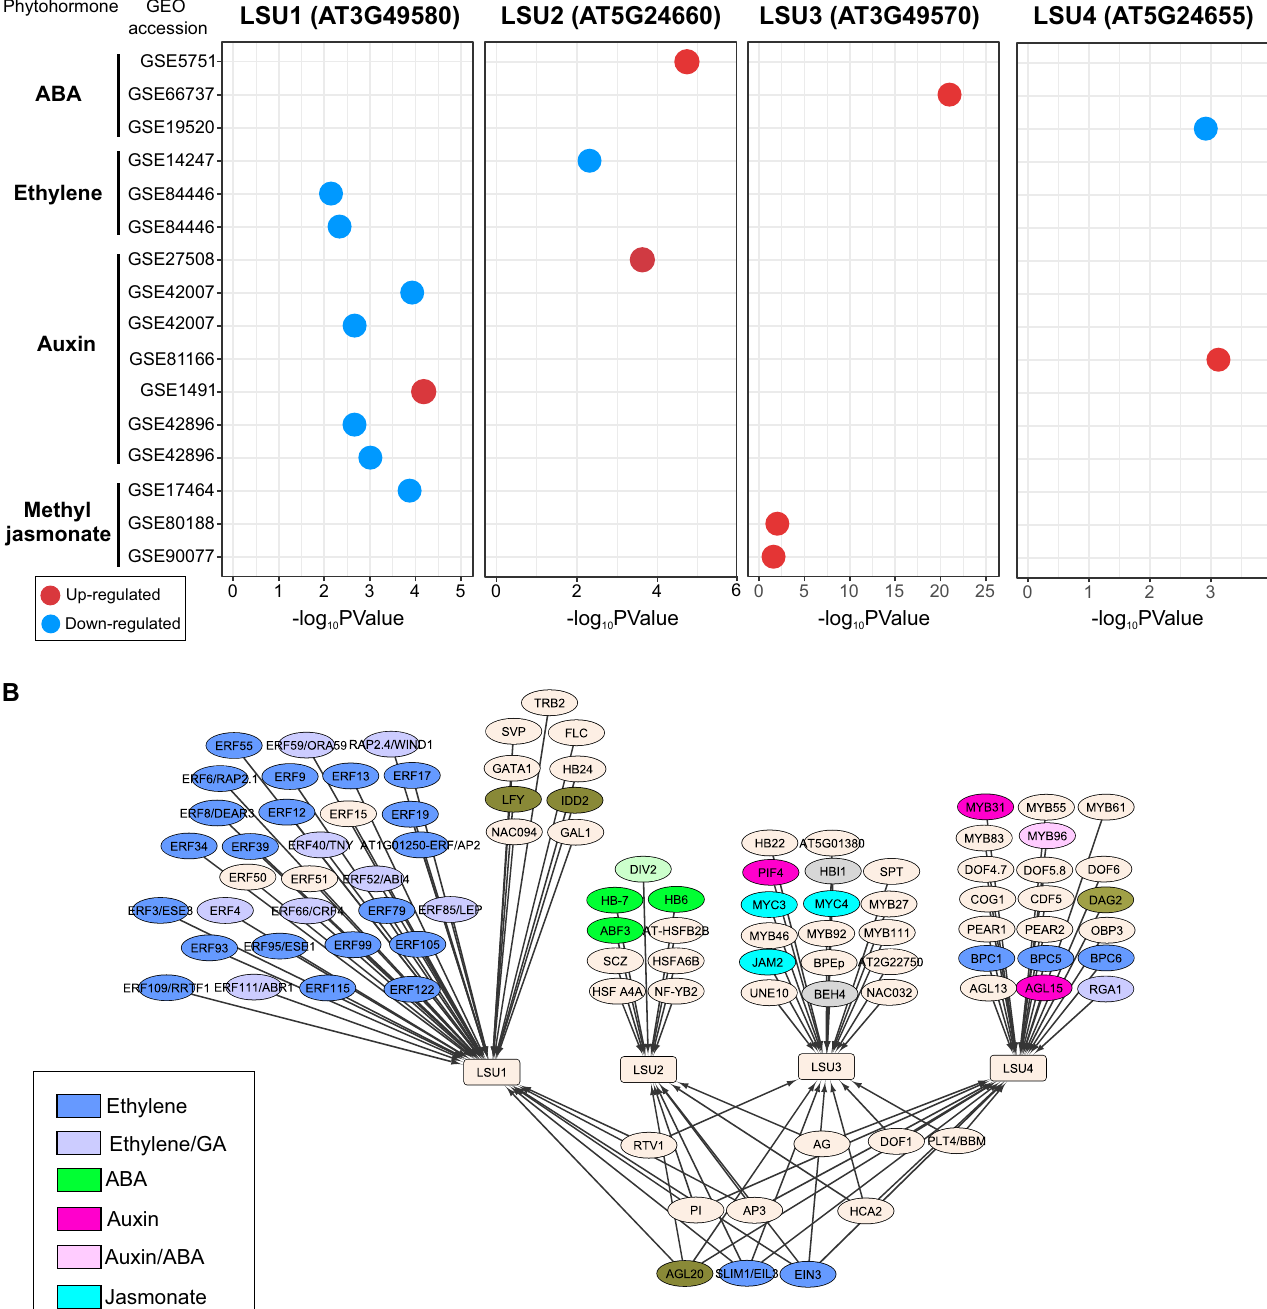
Figure 3. The Arabidopsis LSU genes significantly respond to different phytohormone treatments ( A ), and the analysis of gene regulatory network ( B ) predicted that contrasting groups of phytohormone- related transcription factors regulate each LSU gene. Identification of the significant response of LSU genes to phytohormone treatments was performed by using transcriptome datasets available in the Plant Regulomics database [49]. The regulatory interactions between LSU genes and transcription factors were obtained PlantRegMap